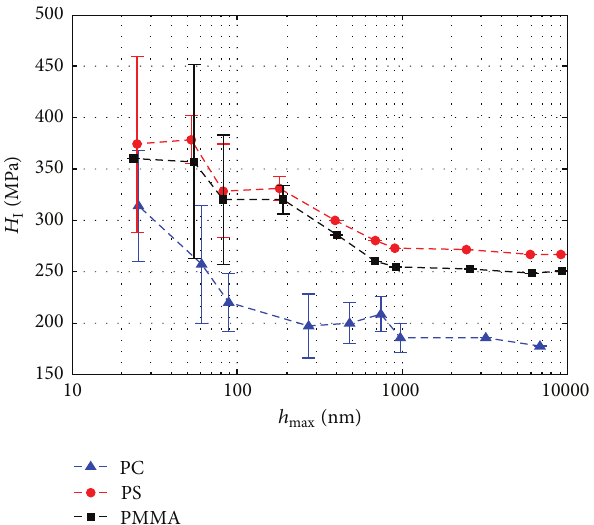
Figure 14: Indentation hardness of thermoplastic polymers obtained with 10s loading, holding, and unloading times together with 0.1 s −1 strain rate [15].